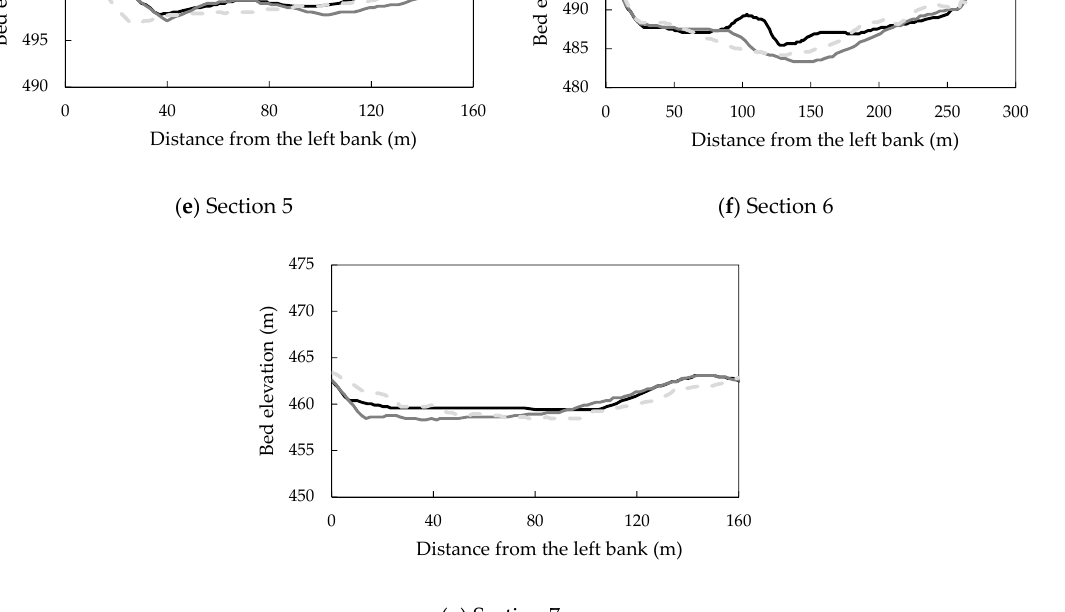
Figure 7. Comparisons between the measurement and simulation at seven cross sections. Note: the black line ‘ ’ indicates the initial bed location (12 January 2009); the grey line ‘ ’ is the measured bed location (29 August 2009); the dash line ‘ ’ is the simulated bed location (29 August 2009).